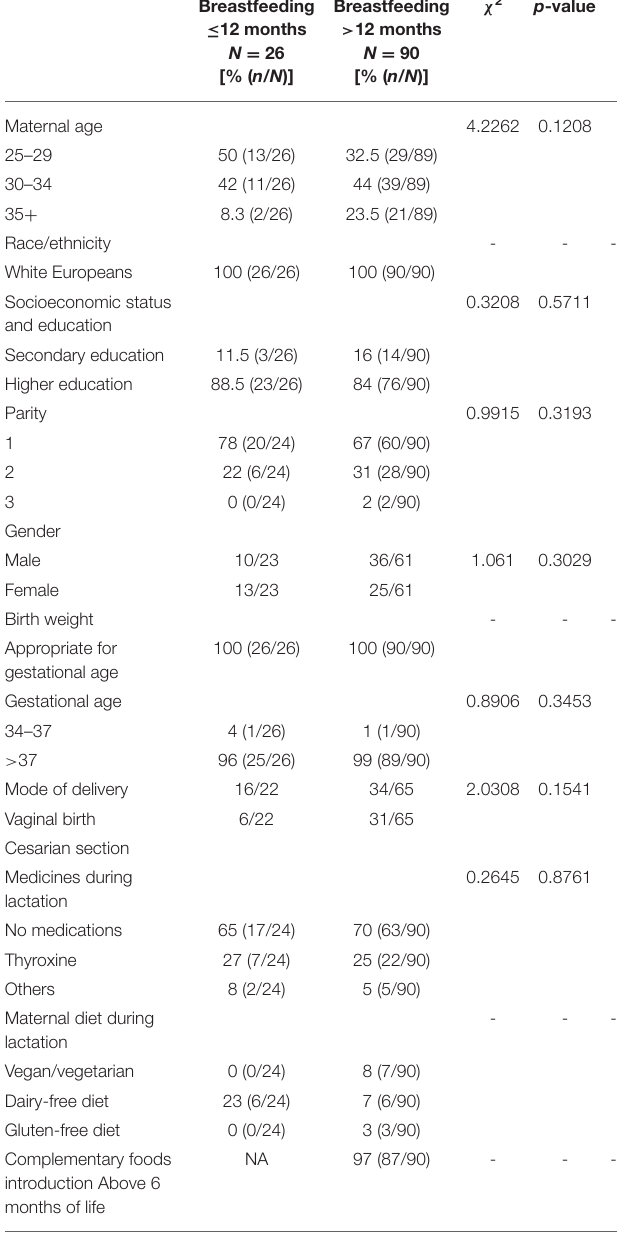
TABLE 1 | Characteristics of the study